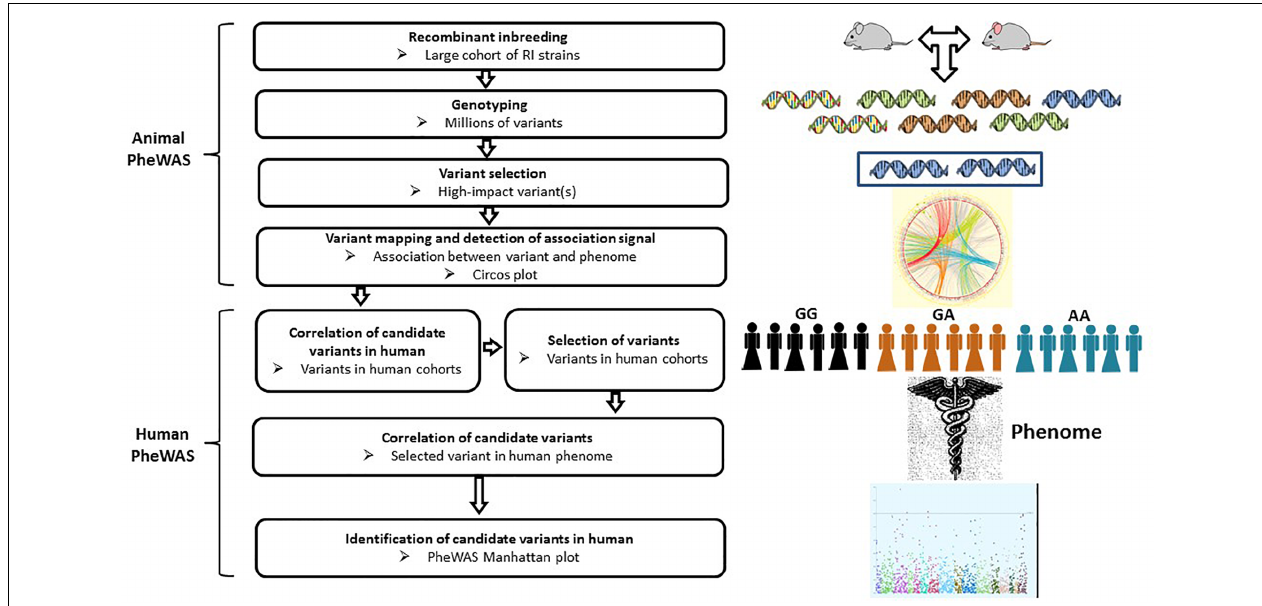
FIGURE 4 | Workflow of PheWAS. The PheWAS can start with animal or directly with human cohorts. A typical approach is to identify high-impact variants within the RI strains, then correlate these variants with the mouse phenome, followed by validation of candidate variants in human